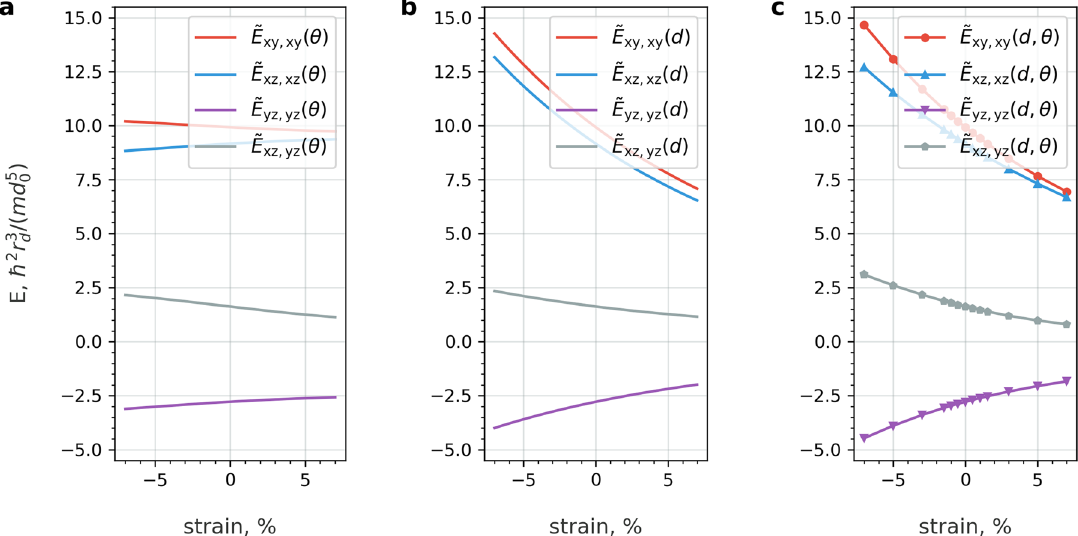
Fig. 3 Dependency of Slater-Koster Ir-Ir integrals on strain. Slater-Koster integrals for rotated NN orbitals ~ E as a function of a octahedra in- plane rotation angle θ , b Ir-Ir distance d , c both θ and d (calculated using values of θ and d extracted from DFT shown in Fig. 2a).